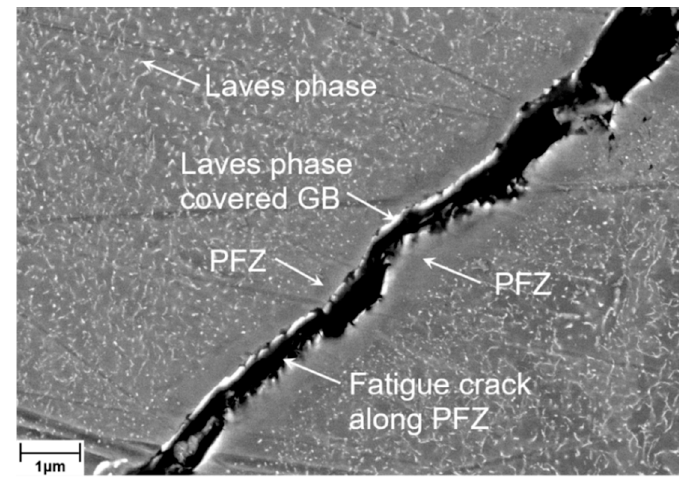
Figure 23. Fatigue cracking within particle-free zones (PFZs) in conventionally produced and higher tungsten-alloyed HiperFer.